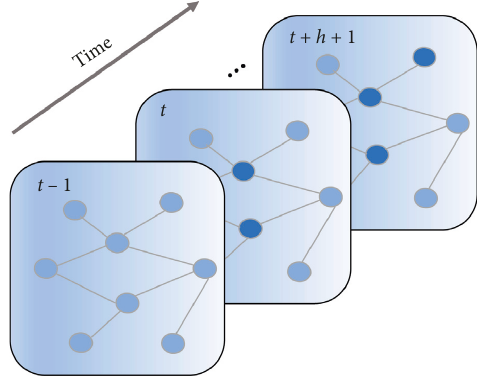
Figure 2: Graph-structured traffic